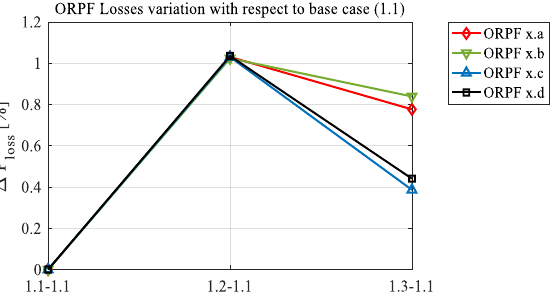
Figure 24. ORPF 1.2 and ORPF 1.3 power losses with respect to ORPF 1.1.